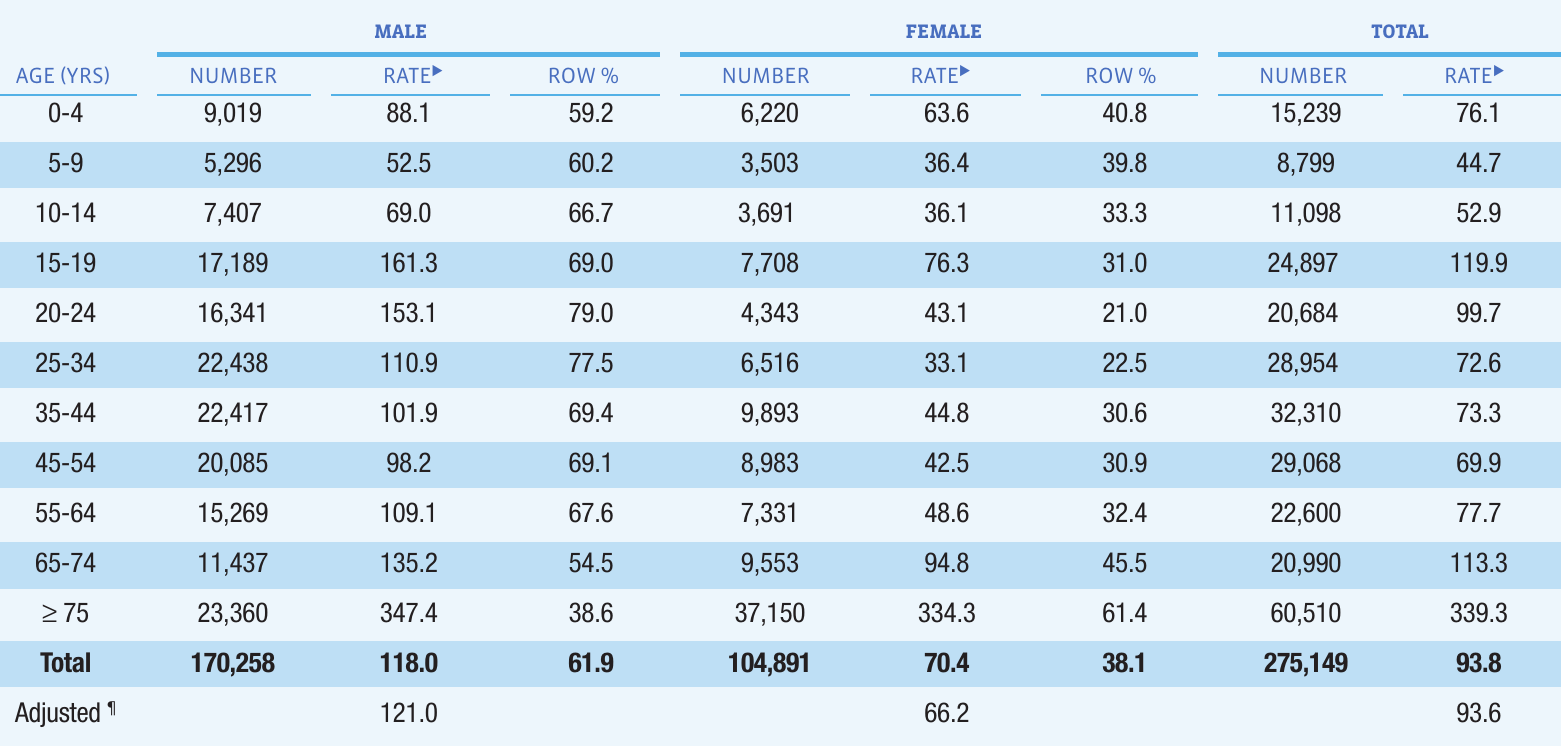
TABLE 9: Estimated Average Annual Numbers, Rates, and Percentages of Traumatic Brain Injury-Related Hospitalizations, by Age Group and Sex, United States,